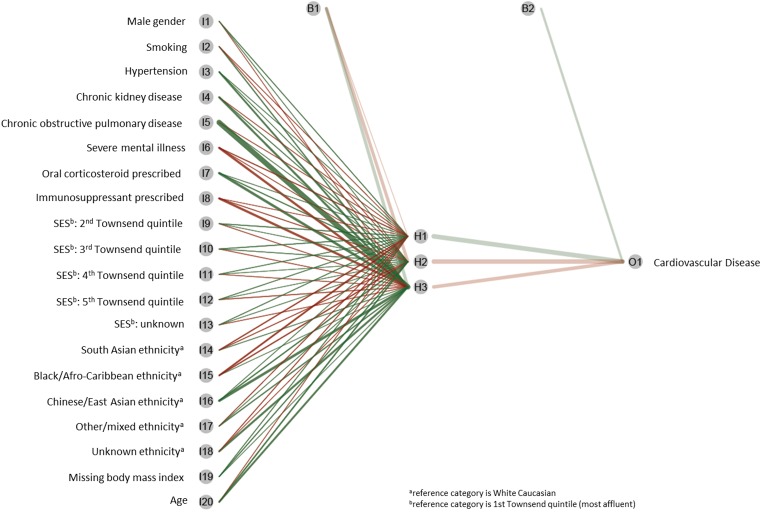
Illuminating “black-box” understanding of machine-learning neural networks: visualization of the risk factors and their association with cardiovascular disease developed from CPRD primary care study population.Green lines are positive predictors, red lines are negative predictors, and the thickness of the line represents the weight (importance) of the risk factor to the outcome.